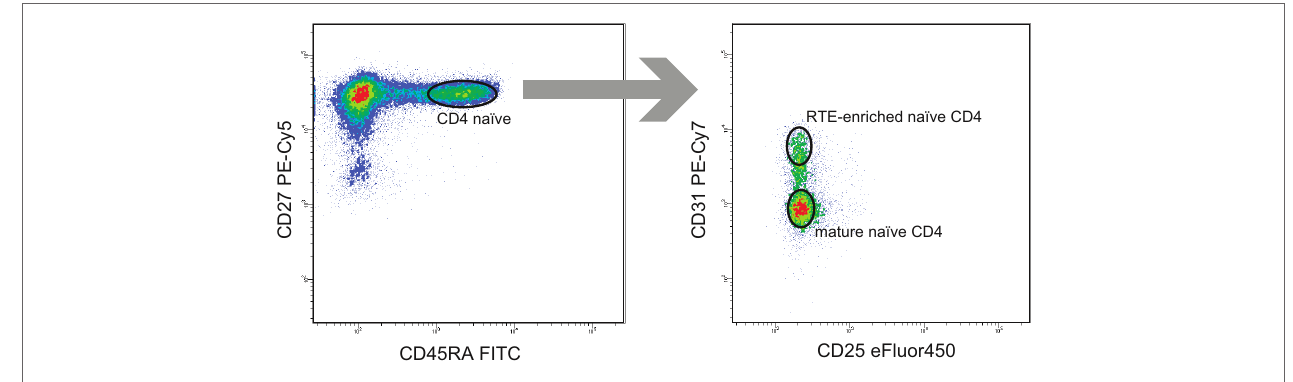
FigUre 4 | Recent thymic emigrant (RTE)-enriched and non-RTE naïve CD4 T cell gating strategy. 50,000 events were shown on the left